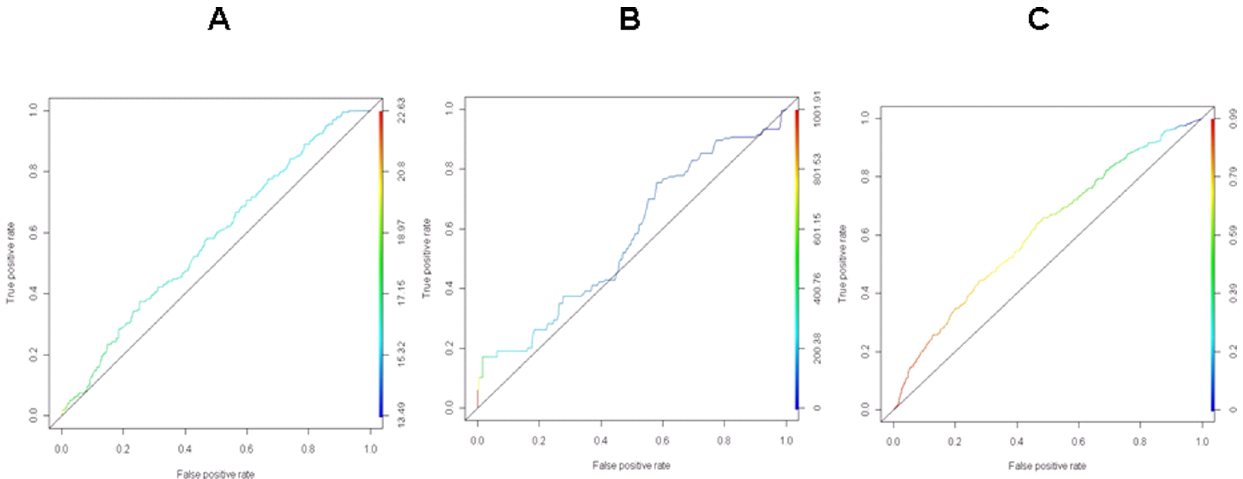
Figure 3. Individual performance of foundational prediction algorithms. The three prediction algorithms were evaluated using ROC curves, which plot the true positive rate (sensitivity) and the false positive rate (1-specificity) at various score thresholds. TarBase was used as gold standard. The line of no-discrimination was drawn from the left bottom to the top right corners. (A) miRanda vs. TarBase; (B) PicTar vs. TarBase; and (C) TargetScan vs. TarBase.